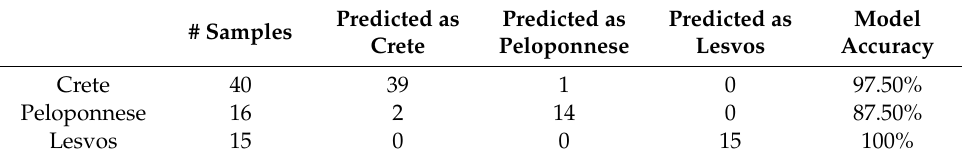
Table 3. PLS-DA classification of the olive oil samples using Raman spectra. Predicted as Predicted as Predicted as # Samples Crete Peloponnese Lesvos